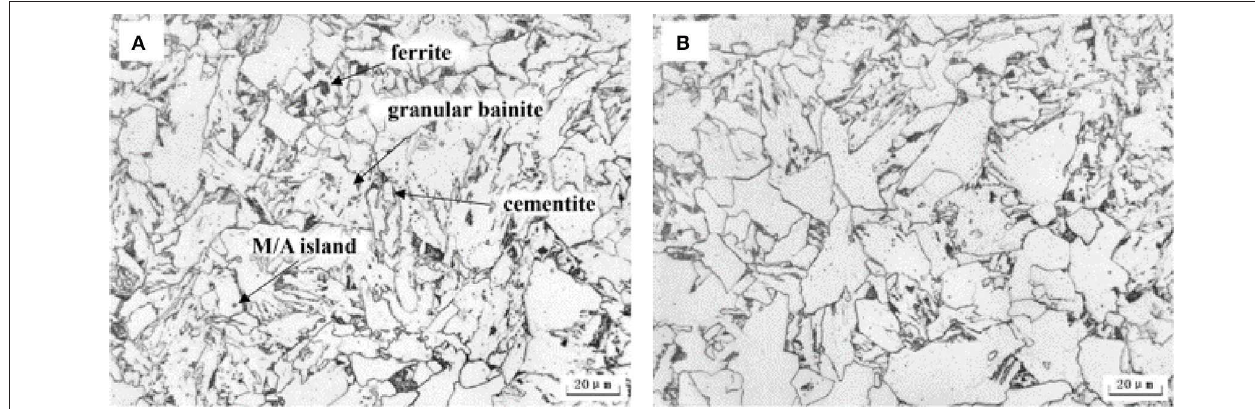
FIGURE 4 | Microstructure of CB10 steel after HIC. (A) Test sample #1, (B) test sample #2.